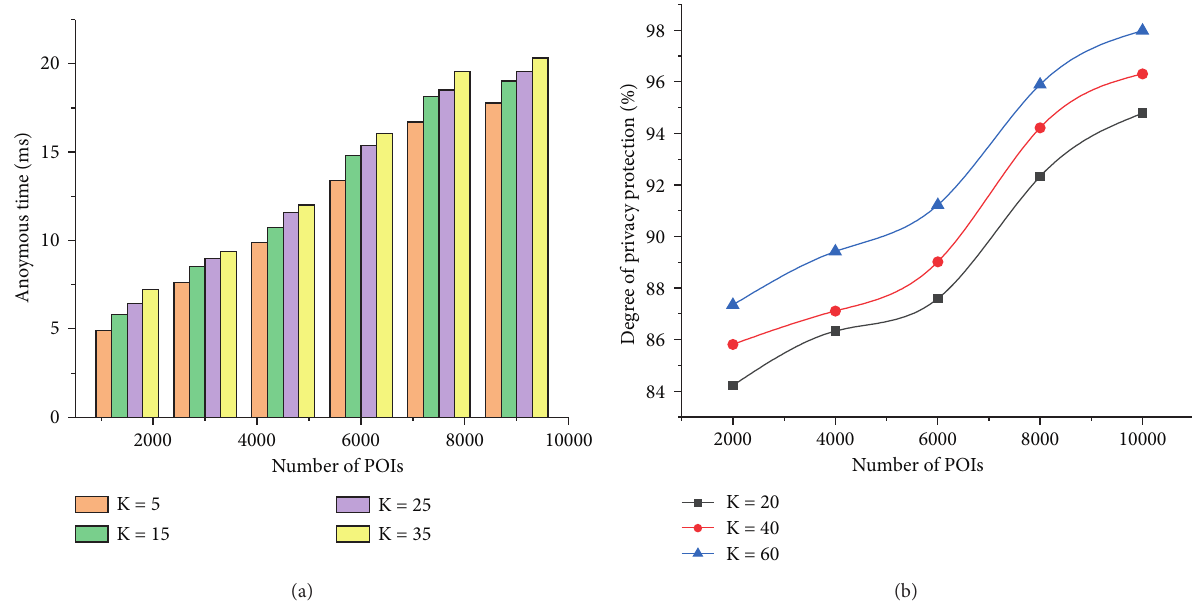
Figure 6: Comparison of the influence of POI and K on this scheme. (a) Influence of POI and K on anonymous time. (b) Influence of POI and K on privacy protection degree.